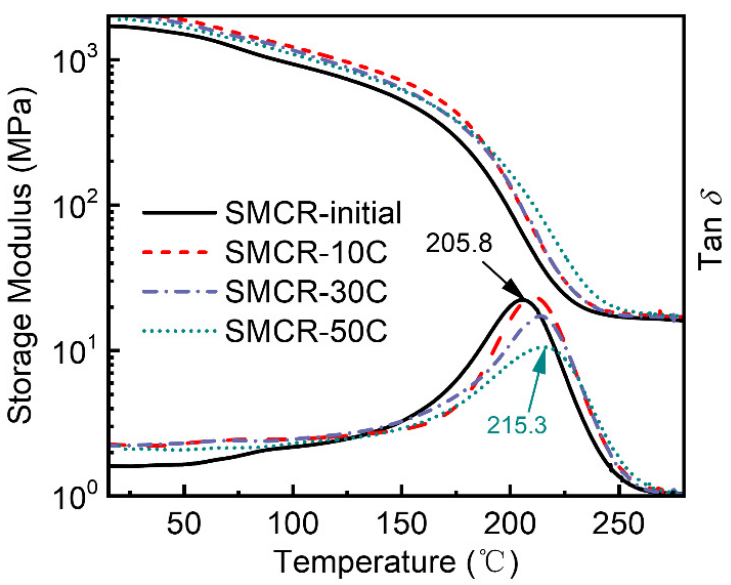
Figure 4. DMA curves of SMCR before and after vacuum thermal cycling. The switching temperature of the SMCR shape memory process was determined to be ~210 ◦ C (T trans = T g ), which was considered to be effective for the shape memory process. When the temperature was lower than T trans , SMCR was in the glassy state and had a high storage modulus. At this time, the activity of the internal molecular segment of SMCR was low, and its macroscopic shape was locked. When the temperature was higher than T trans , the storage modulus of SMCR decreased sharply and tended to be stable with the further increase in temperature. The activity of the internal molecular chain of SMCR was high, which was reflected in the programmability of its macroscopic shape. At room temperature, SMCR can be regarded as a typical hard plastic. At this time, the molecular chain of SMCR was in the lowest energy state. When the temperature was greater than T trans , SMCR transformed into a soft elastomer, which led to easy deformation under external force. This macroscopic deformation corresponded to a conformational change in the molecular chain, resulting in an enhanced energy state of the SMCR. When the temperature was less than T trans , the deformation of SMCR was maintained even when the external force was removed. It can be simply understood that the molecular chain of the deformed SMCR froze after cooling down, the SMCR matrix maintained a dynamic barrier in a high-energy state, and the energy was stored. Once this kinetic barrier was removed due to increased segment mobility, the stored energy was released, driving the molecular chain back to a lower energy state. This was manifested in the macroscopic shape of the SMCR returning to its original shape. In brief, the driving force of the shape memory behavior of SMCR came from rubber elasticity, that is, the elastic resilience stored in the polymer chain when the polymer network structure was programmed to a temporary